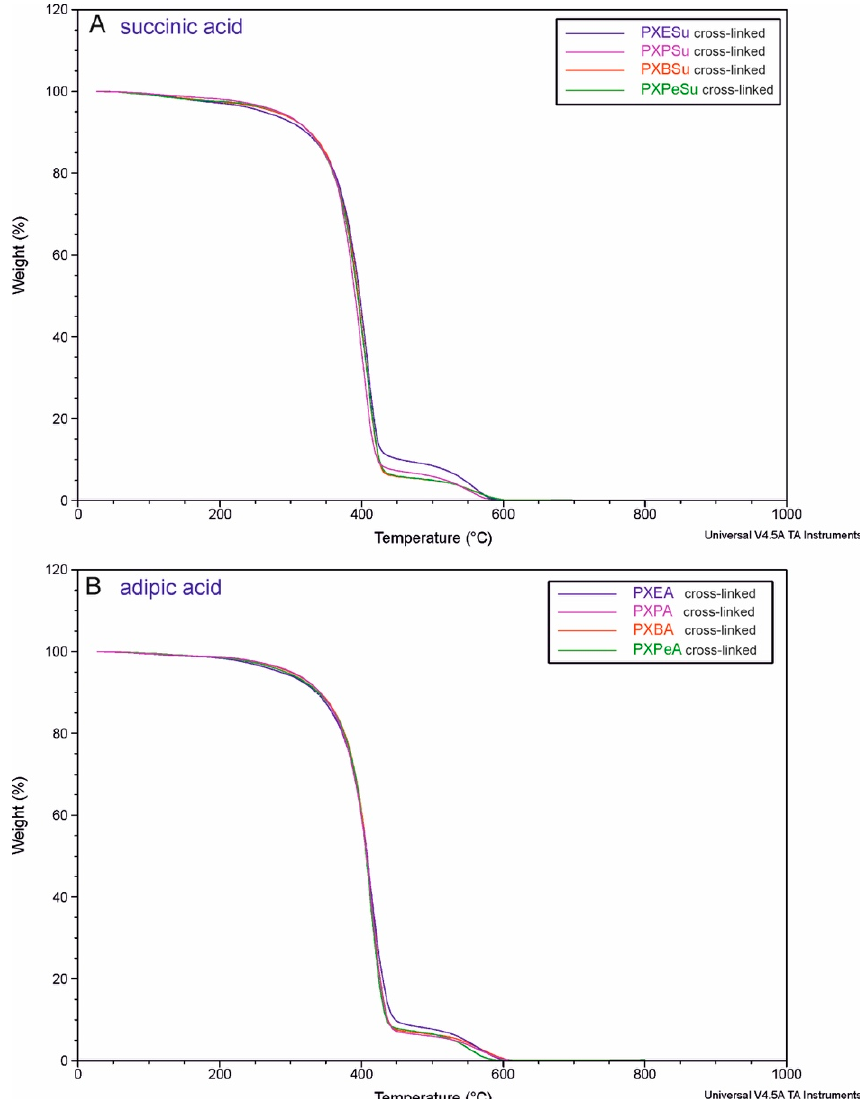
Figure 15. Thermogravimetric analysis (TGA) of PXESu, PXPSu, PXBSu, PXPeSu ( A ) and PXEA, PXPA, PXBA, and PXPeA ( B ) after synthesis.